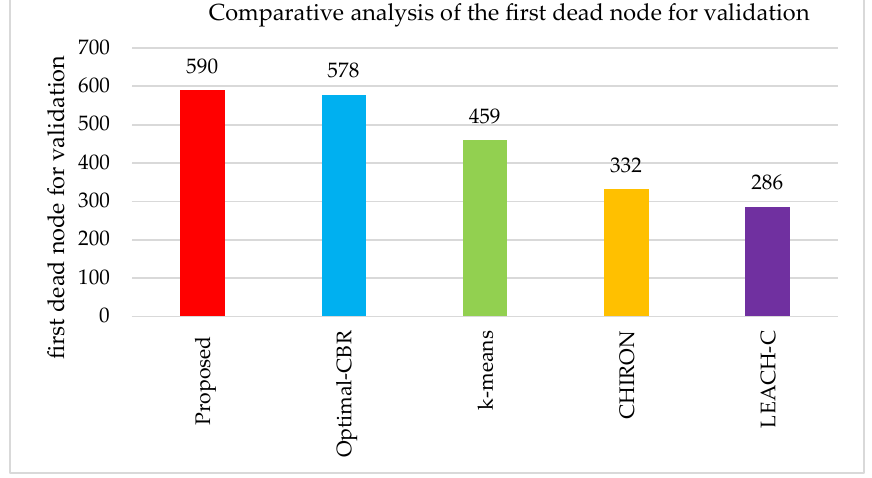
Figure 3. Comparative analysis of the first dead node for validation by the number of rounds in various methods.